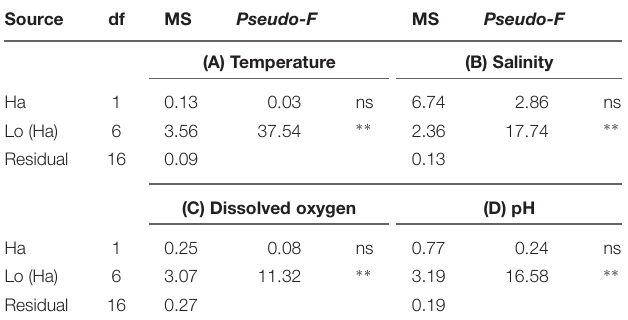
TABLE 2 | perMANOVA comparing bacterial community structure (Bray–Curtis) and composition (Jaccard) sampled directly from natural rocky shores and artificial seawalls ((A) Plots) and from substrate experimentally deployed in the habitat ((B) Recruitment